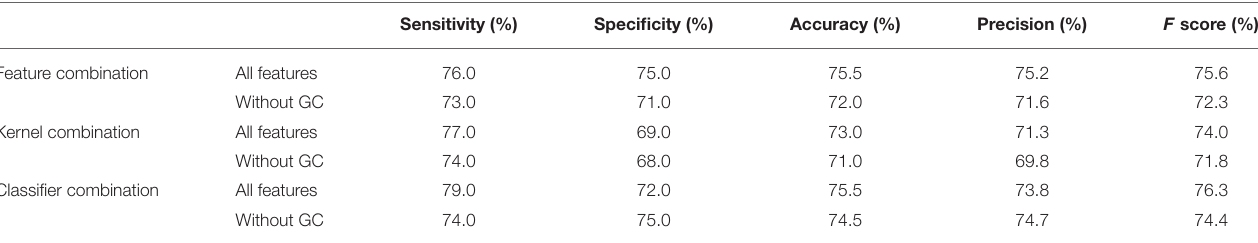
TABLE 3 | Classification results of the three tested